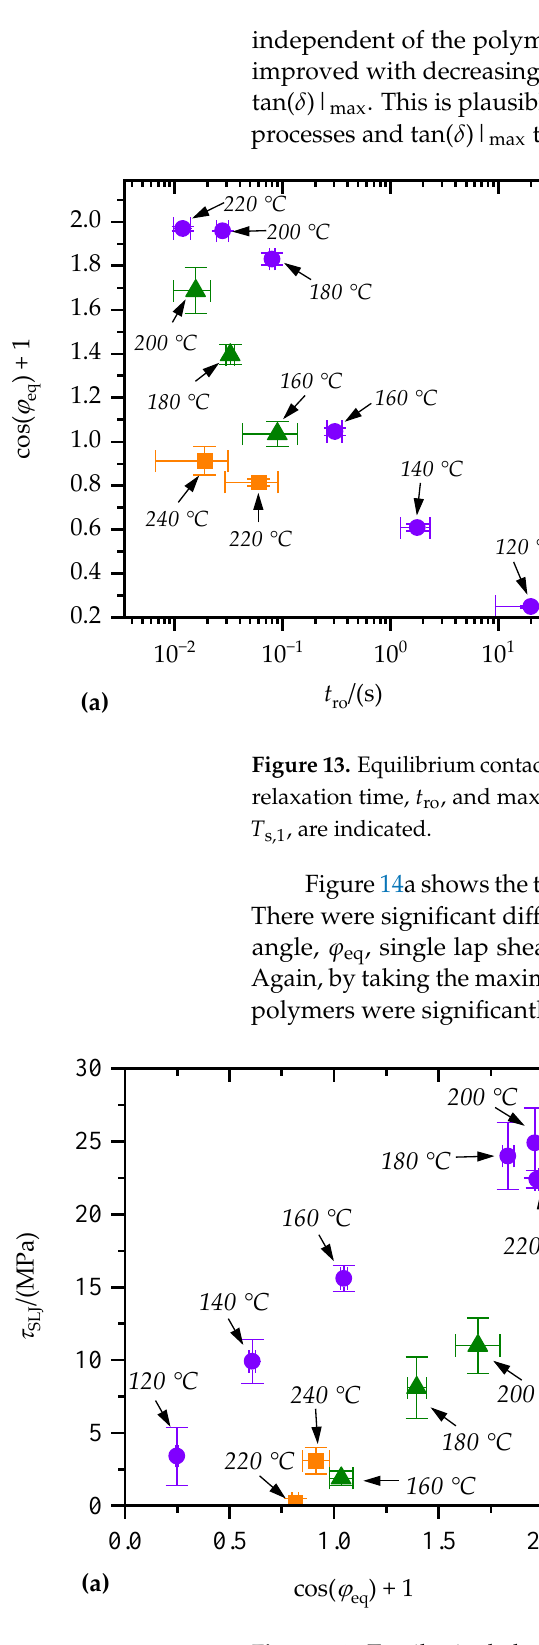
Figure 14. Tensile single-lap-shear strength, τ SLJ , as a function of ( a ) equilibrium contact angle, φ eq , and ( b ) equilibrium contact angle, φ eq , and maximum loss factor, tan( δ )| max . Corresponding sub- strate temperatures, T s,1 , are indicated.